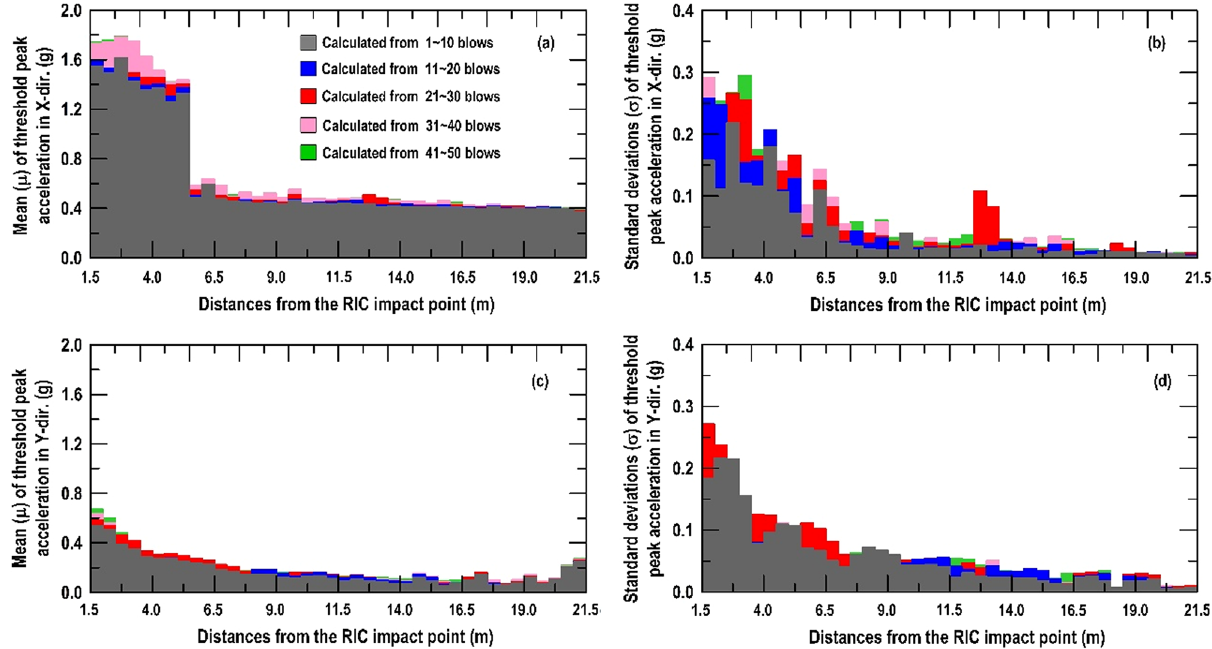
Figure 14. Calculated normal distributions results from the horizontally embedded SAA string recorded: ( a , c ) mean of threshold peak acceleration in X-direction and Y-direction; ( b , d ) standard deviation of threshold peak acceleration in X-direction and